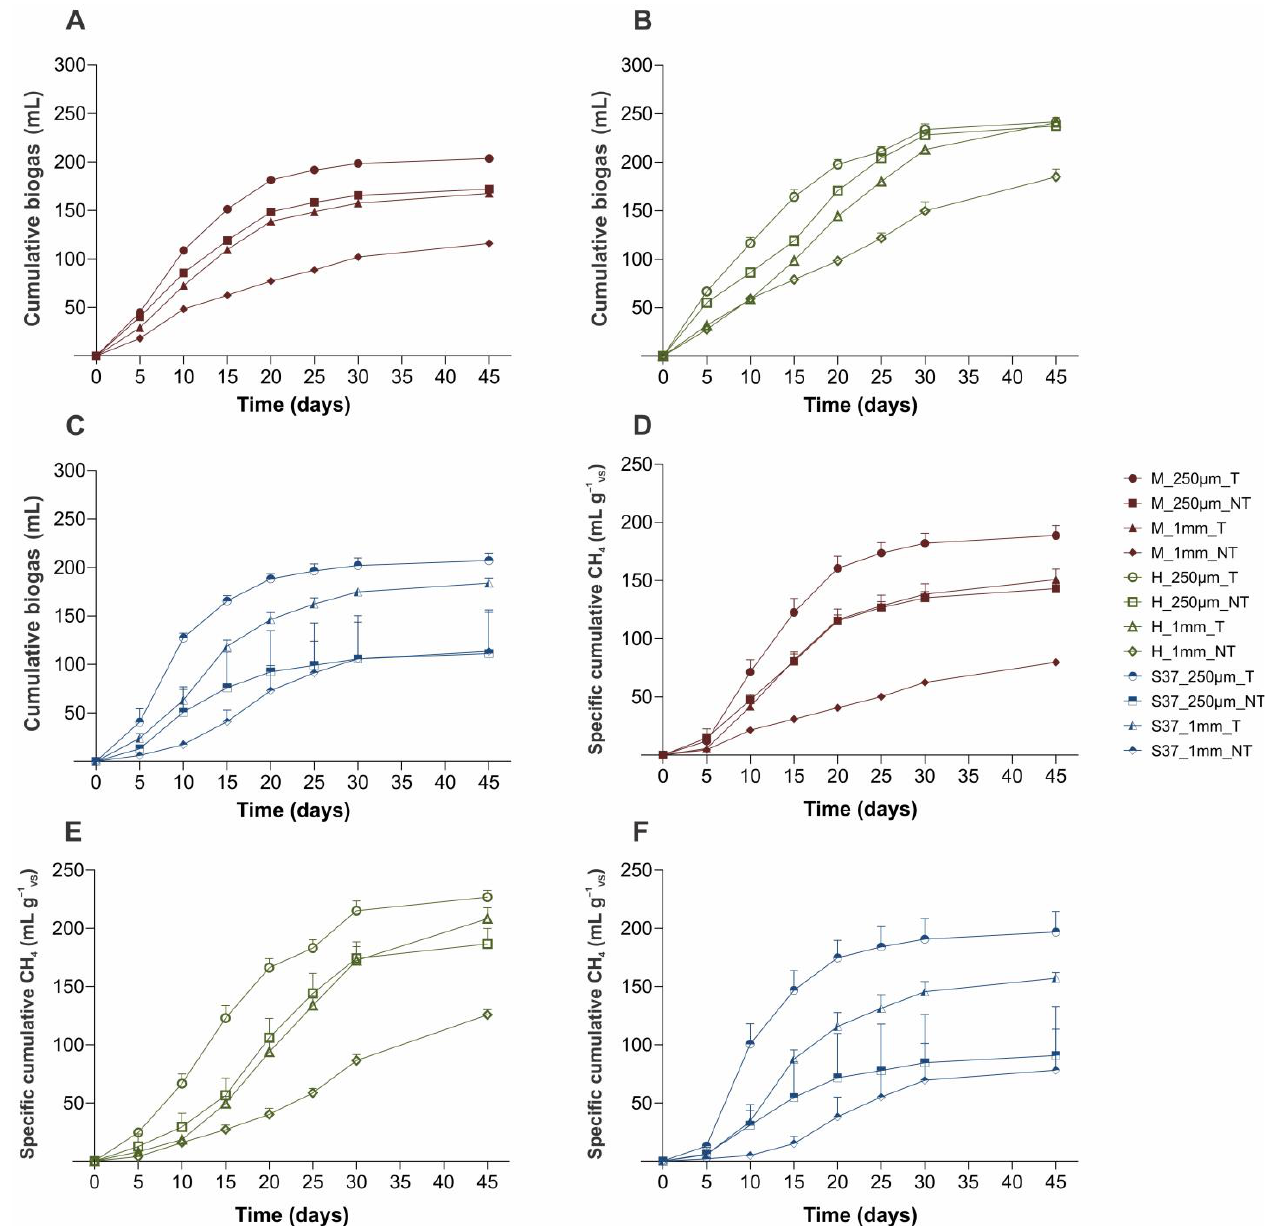
Figure 1. ( A – C ) Cumulative biogas; ( D – F ) Specific cumulative methane; over 45 days of cultivation in the midgut (M) and hindgut (H) larva cultures and Szarvas soda lake (S37) culture. The error bars represent the standard deviation of the mean of n = 3 (invisible error bars are smaller than the symbol).